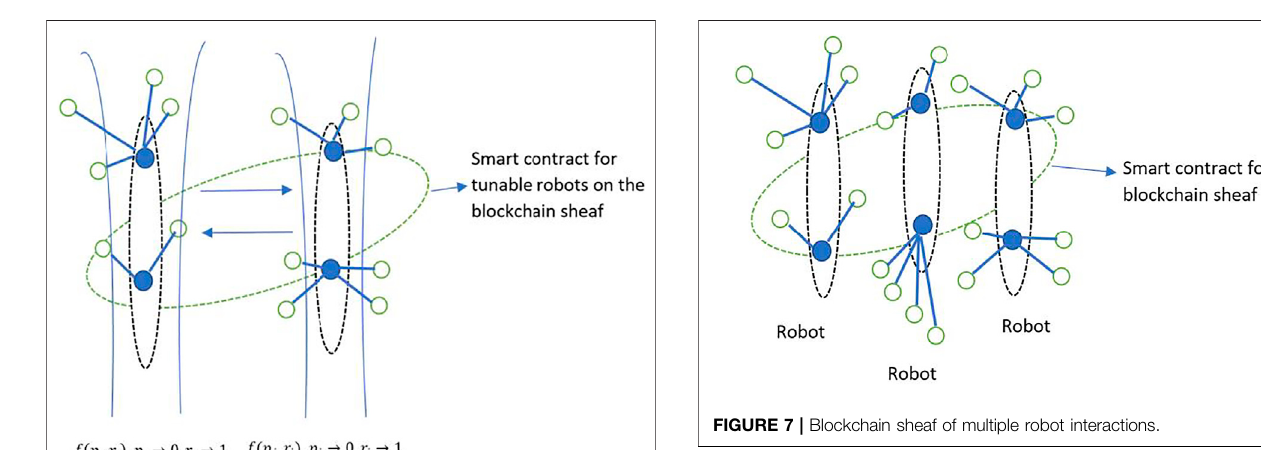
FIGURE 7 | Blockchain sheaf of multiple robot